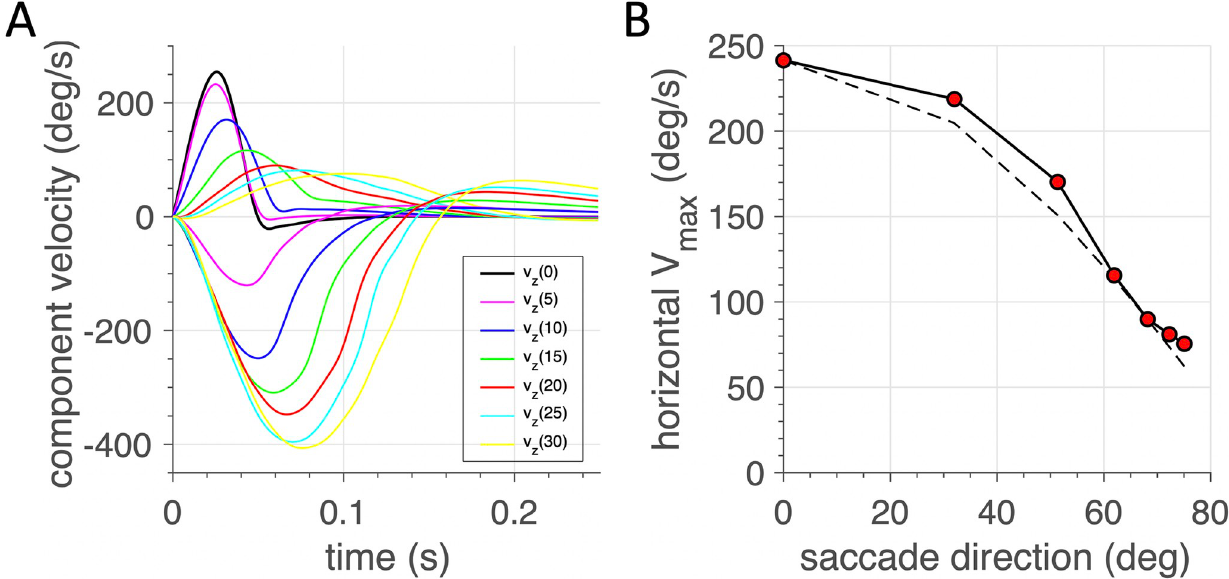
Fig 11. Component stretching in oblique saccades (after J AED minimization). In these examples, the horizontal component was kept fixed at 8.0 deg, while the vertical component varied from 0 to 30 deg in 5 deg steps. (A) Horizontal and (inverted) vertical velocity profiles of the oblique saccades. Note that the velocity profiles approximately match in duration. This is especially clear for the larger ( � 15 deg) vertical components (green, red, cyan and yellow traces). (B) Peak velocity of the horizontal component depends on the saccade direction. Dashed line: cosine prediction for a common-source vectorial drive ([47] see also Table